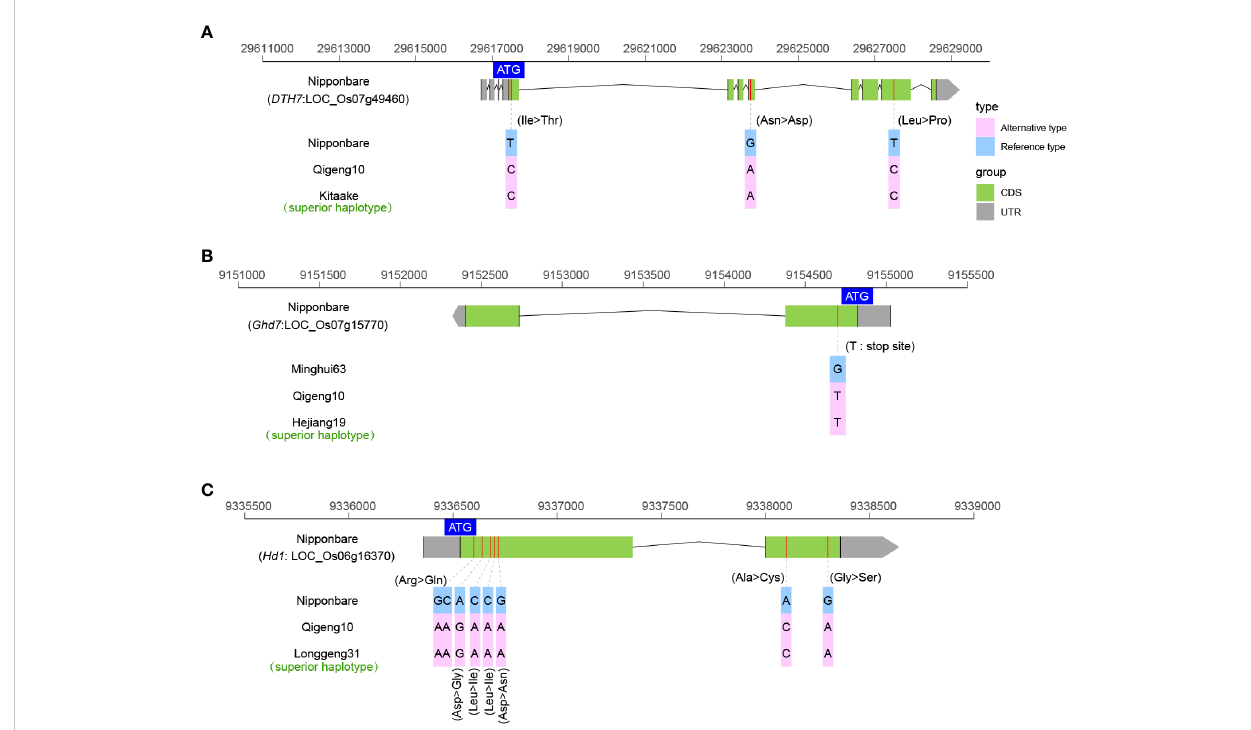
FIGURE 5 The allelic information of sequence variants in DTH7 (A) , Ghd7 (B) , and Hd1 (C) controlling heading date in rice.